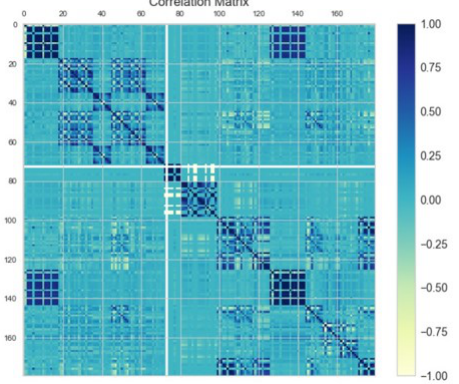
Figure 7. Correlation